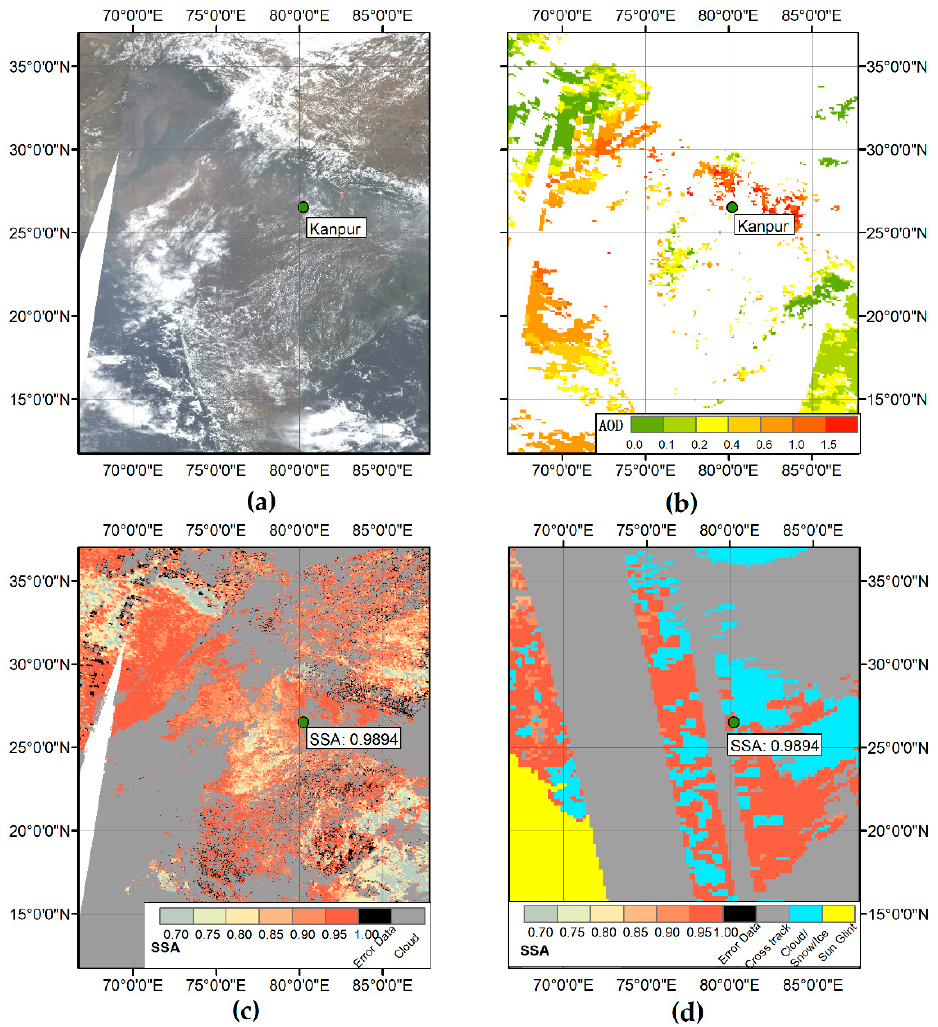
Figure 9. ( a ) True color composite map from MODIS (data came from Terra in South Asia on 25 June 2019), ( b ) AOD map of MOD04, ( c ) SSA retrieval value of our method, ( d ) SSA retrieval value (500 nm) of OMAERUV. The location and inversion SSA values of Kanpur site are marked in figures.